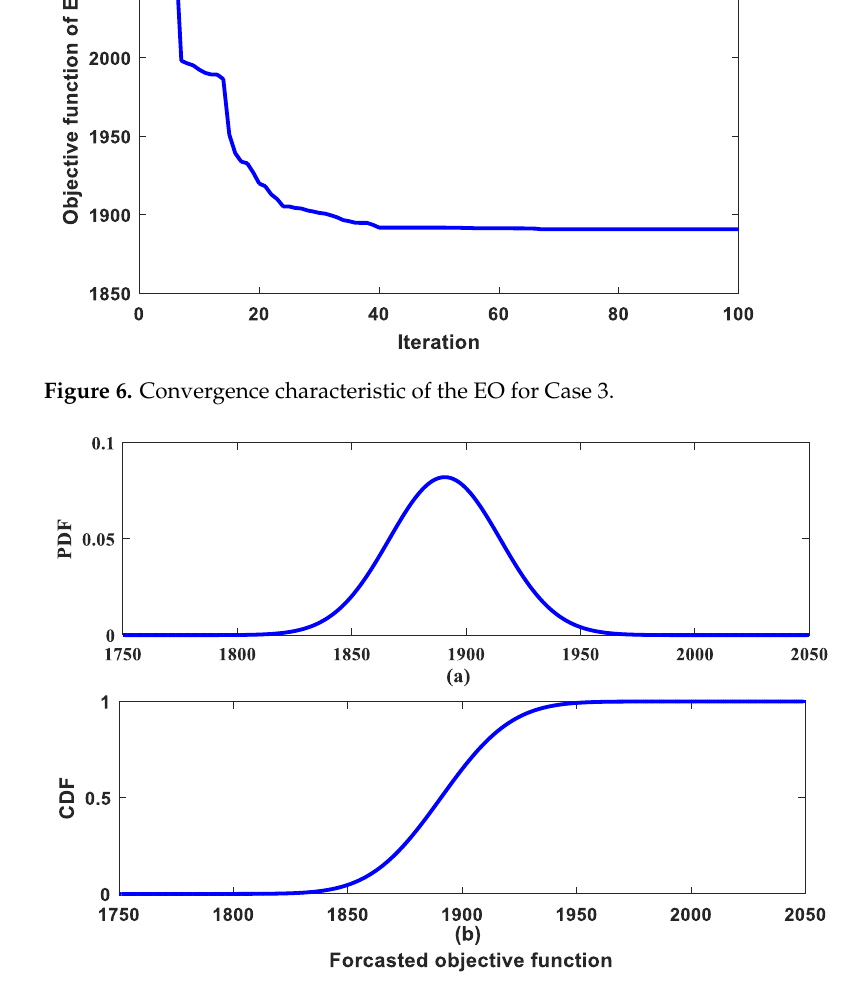
Figure 7. ( a ) Probability density function (PDF); ( b ) cumulative density function (CDF) of fore- casted objective function based on the EO for Case 3. objective function based on the EO for Case